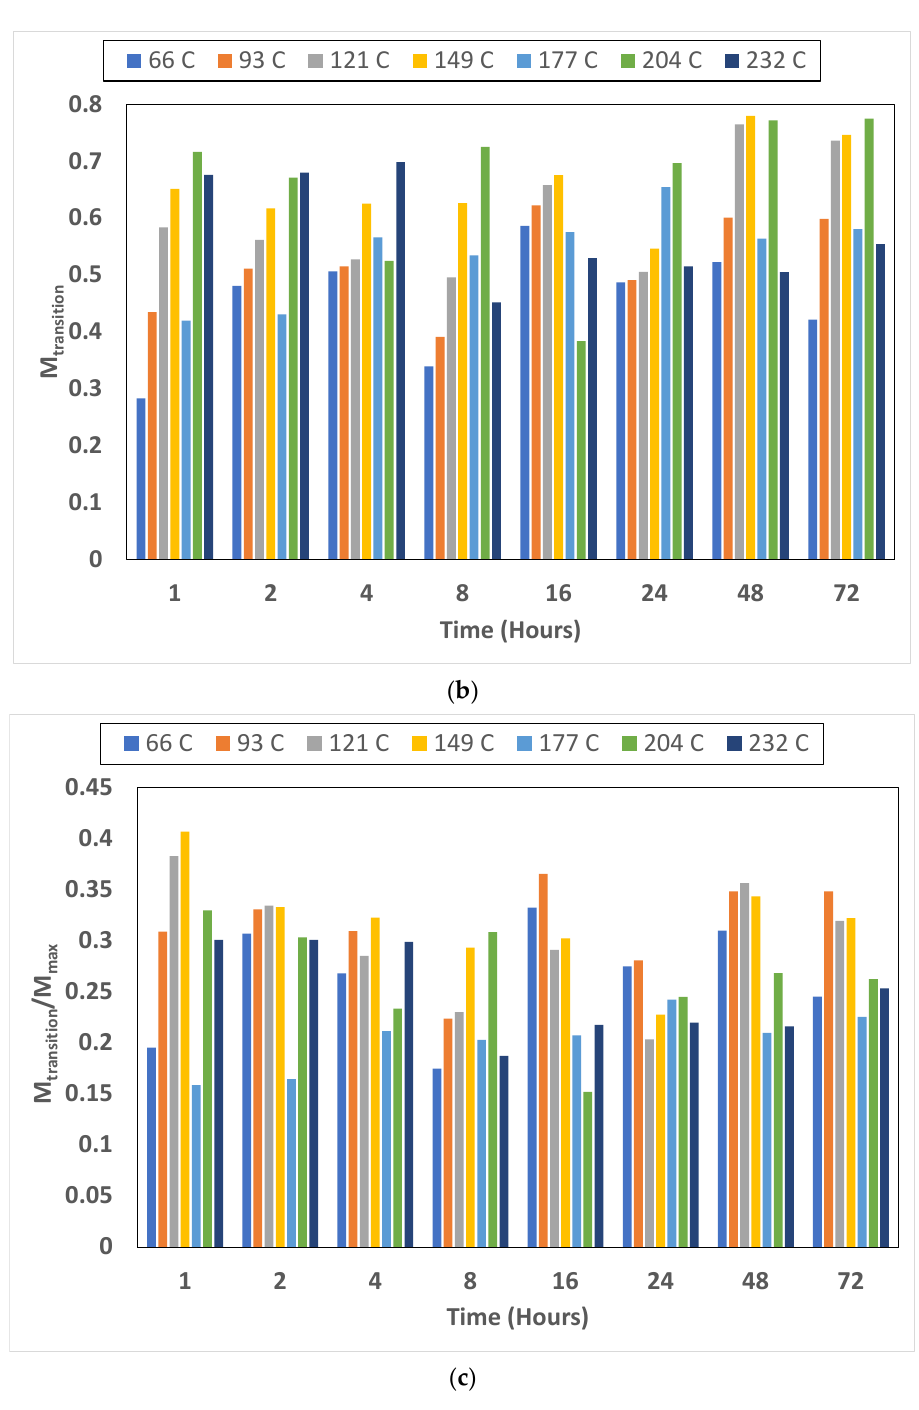
Figure 4. ( a ): Level of maximum water uptake as a function of time and temperature of prior thermal aging. ( b ): Level of water uptake at the transition point as a function of time and temperature of prior thermal aging. ( c ): Ratio of water uptake at the transition point to the maximum uptake as a function of time and temperature of prior thermal aging.